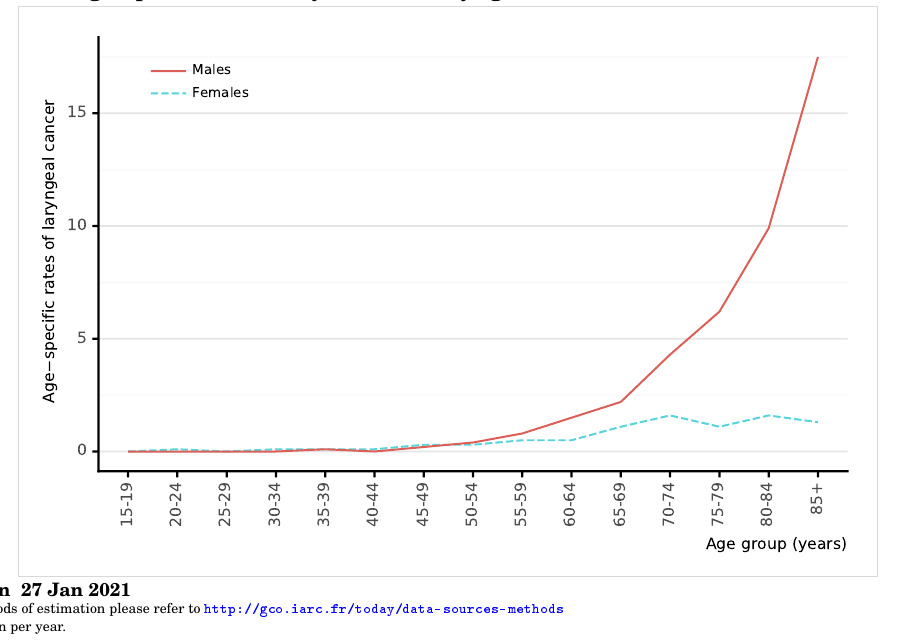
Figure 50: Age-specific mortality rates of laryngeal cancer in Peru (estimates for 2020)